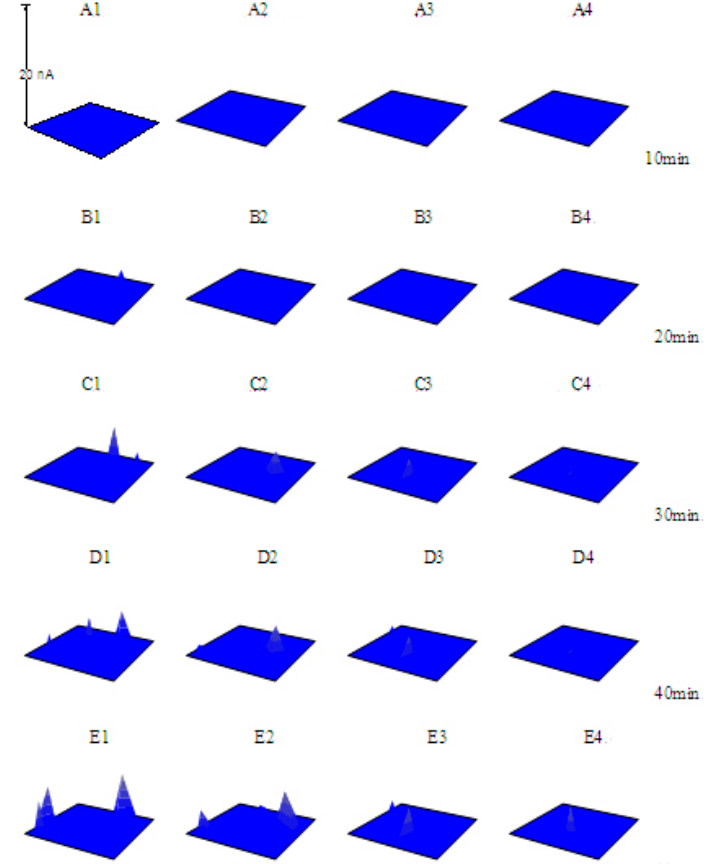
Figure 6. The SECM images of the X70 carbon steel electrodes polarized at − 0.080 V ( E OCP = − 0.330 V) in 0.10 mol / L NaCl + x mol / L NaNO 2 solutions ( A1 – E1 ) x = 0.020; ( A2 – E2 ) x = 0.040; ( A3 – E3 ) x = 0.060; ( A4 – E4 ) x = 0.080.